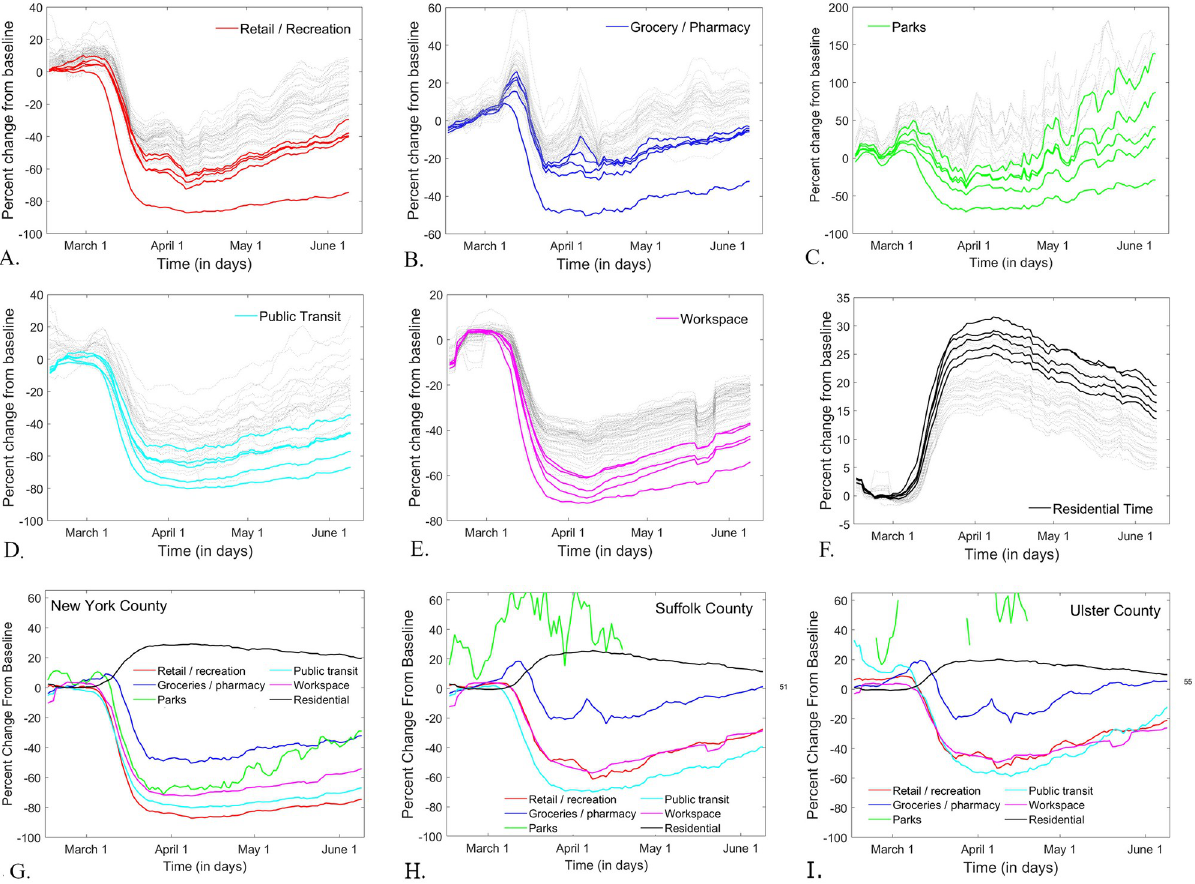
Fig 6. Seven day moving window average time series describing mobility (as reported by Google) to A. Retail and Recreation; B. Grocery and Pharmacy; C. Parks; D. Public Transit; E. Workspace; F. Residential time. New York City counties are shown in thick solid lines; all other counties are shown in grey dotted lines . G-I. Seven day moving window average time series for mobility to all destinations for New York County ( G ); Suffolk County ( H ); Ulster County ( I )